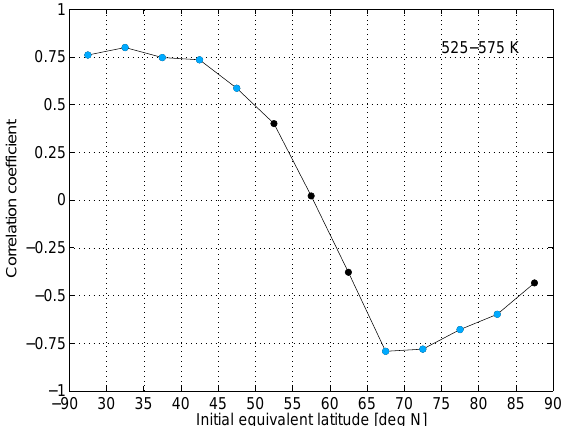
Fig. 8. Correlation of the origin of air inside the polar vortex and vortex mean ozone mixing ratios at 525–575K. Correlation of a time series (1992–2009) of vortex mean ozone mixing ratios in early winter at 525–575K and a time series of the fraction of air in the vortex in early winter at 525–575K originating from the equiv- alent latitude intervals given at the horizontal axis on 1 September. Correlation coefficients significant at the 95% level are shown in blue. Time series are detrended.